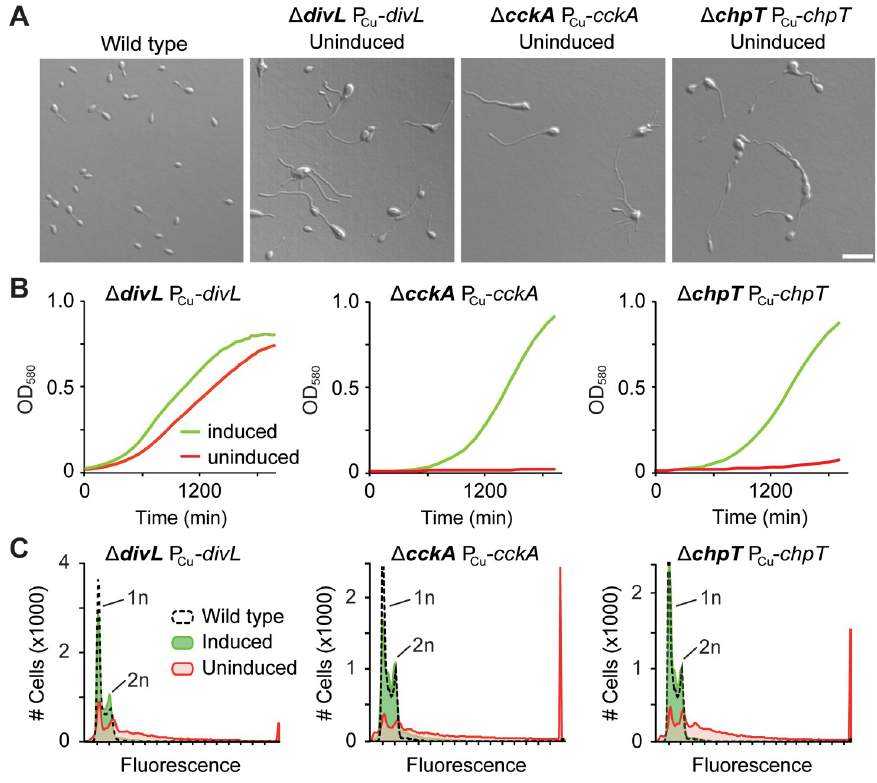
Fig 4. The essential proteins DivL, CckA and ChpT affect cell morphology and chromosome content. (A) DIC images of the H . neptunium wild type and conditional mutants depleted of DivL (OL177), CckA (OL161) and ChpT (OL152). Protein depletion was achieved by cultivation of the strains for at least 24 h in the absence of inducer (300 μ M CuSO 4 ). The scaling of all images is identical. Scale bar: 5 μ m. (B) Growth of conditional divL (OL177), cckA (OL161) and chpT (OL152) mutants under inducing (300 μ M CuSO 4 ) and non-inducing conditions. The curves shown represent the mean of three independent experiments. (C) Flow cytometric analysis showing the DNA content of the indicated conditional mutants under inducing and non-inducing conditions (n = 30,000 cells per conditions). Data obtained for the wild-type strain are shown for comparison. The fluorescence intensities corresponding to one (1n) or two (2n) chromosome equivalents are indicated.